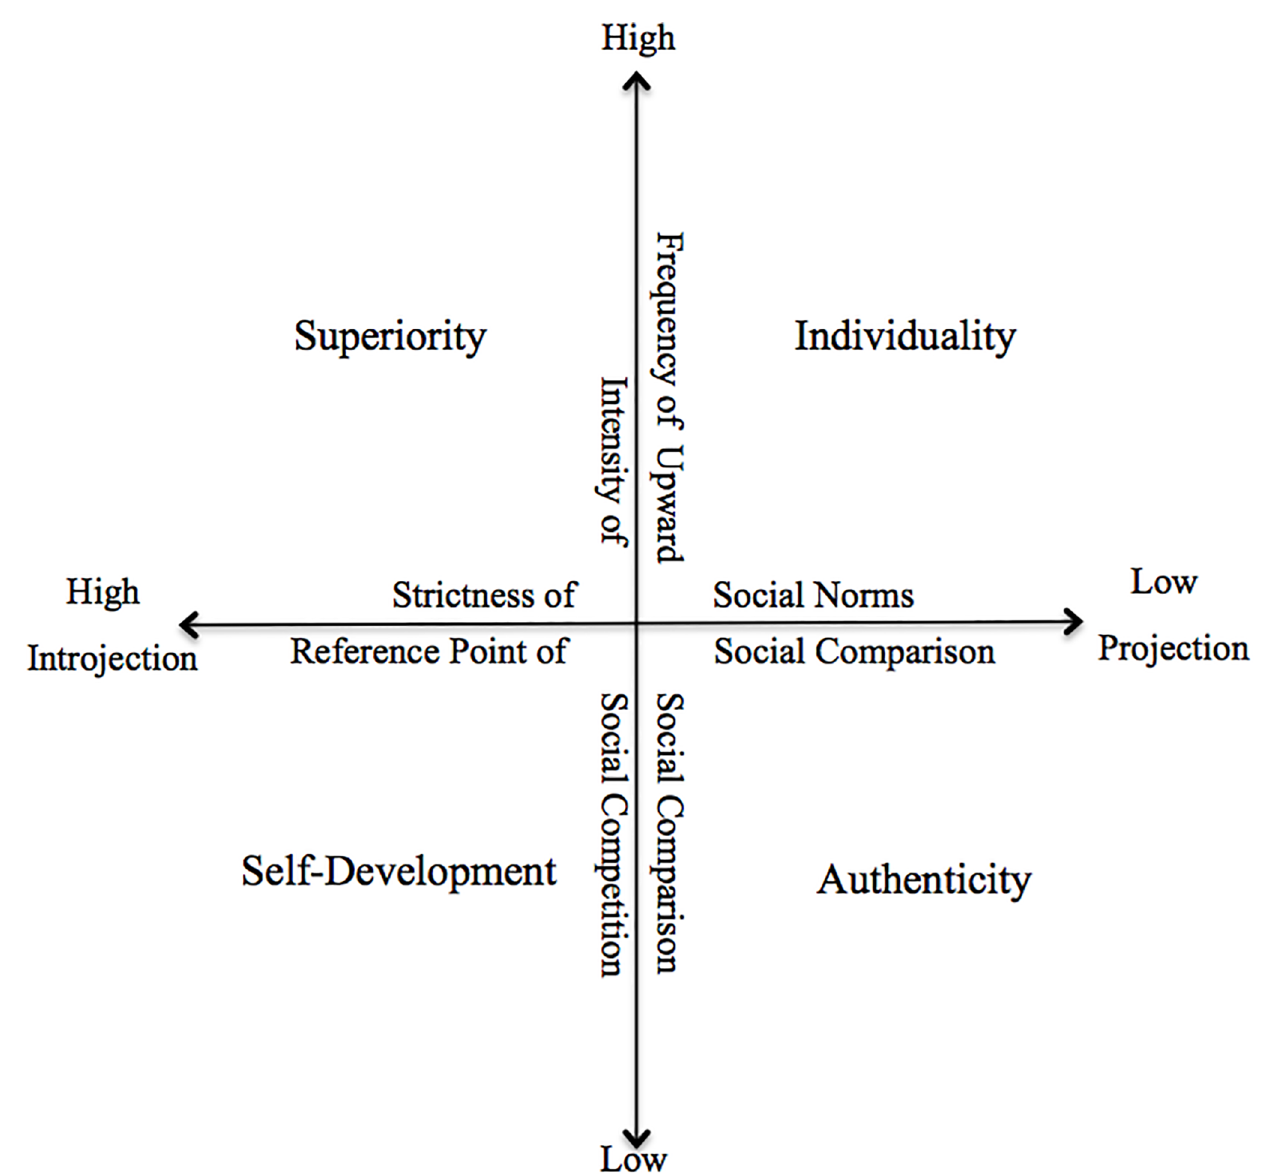
Fig 1. Structural framework and dimensions of